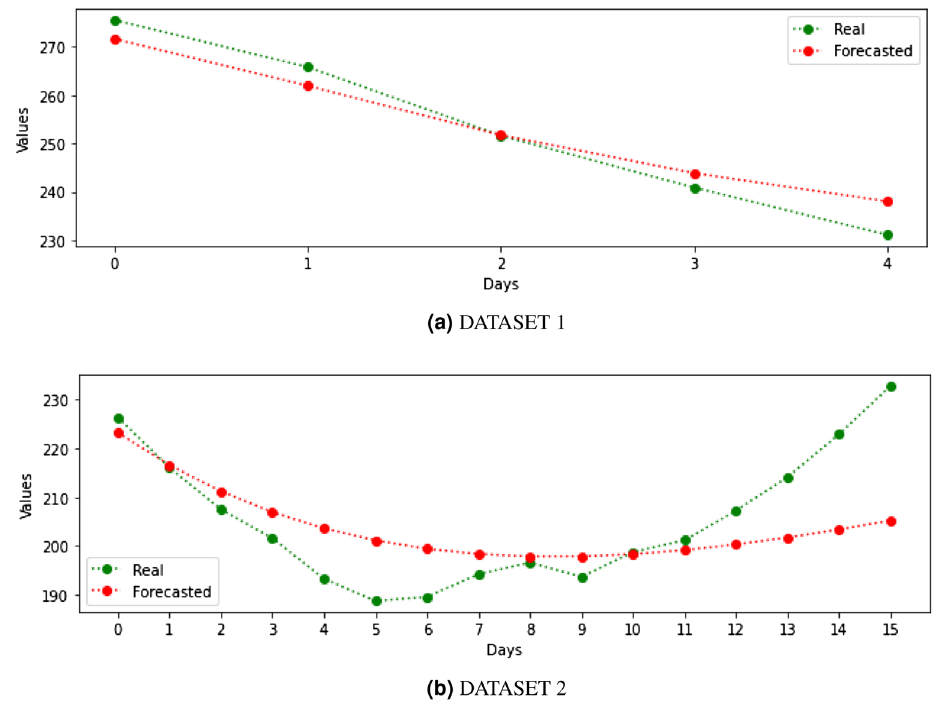
Figure 4. 14-day CI accuracy prediction for both datasets.